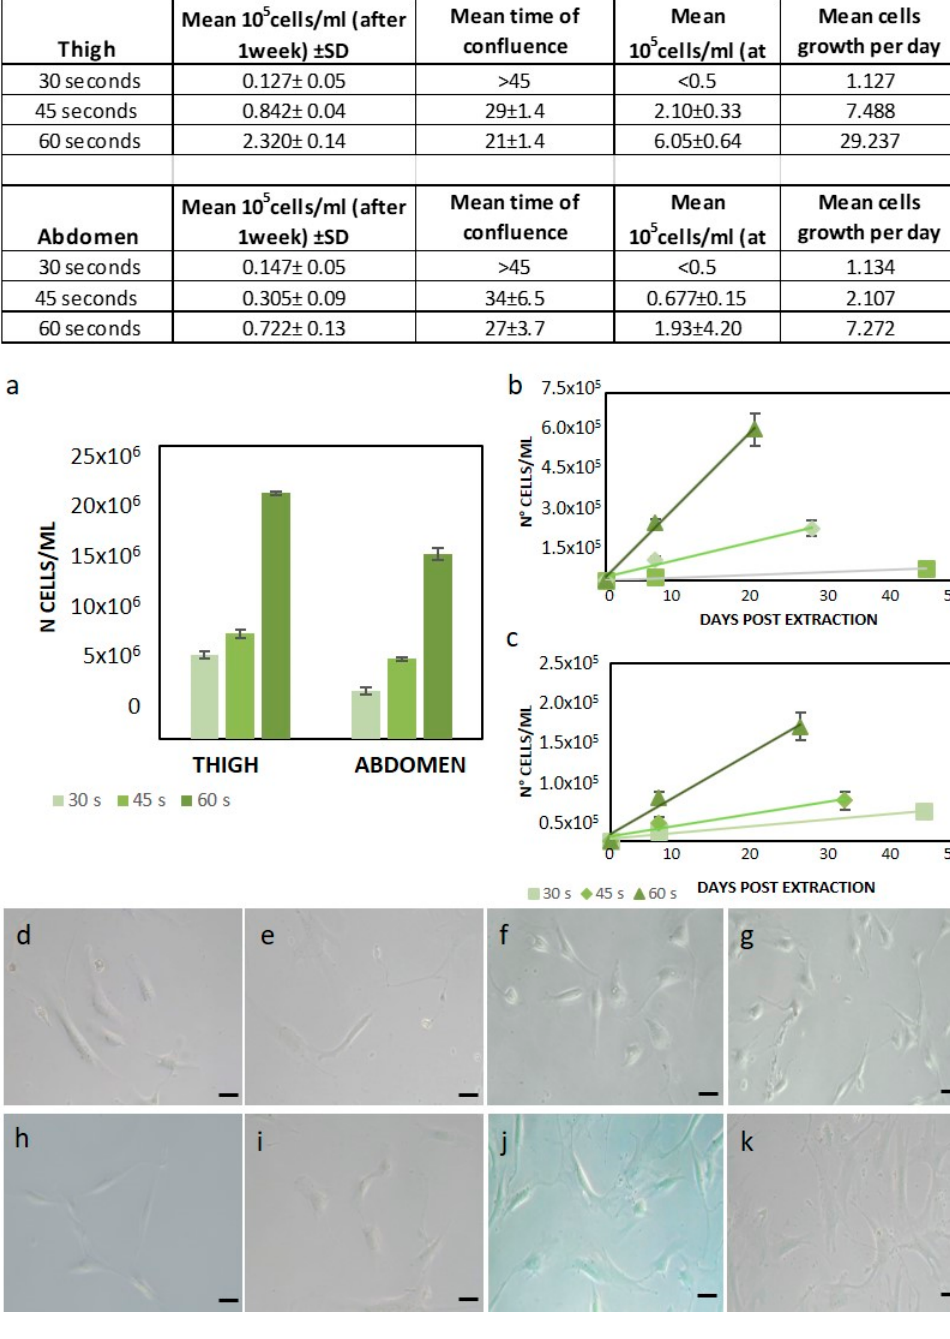
Figure 2. Rigenera ® method optimization. The tabs show all of the results obtained. ( a ) Cell viability test with the trypan blue exclusion method. At passage 0, the number of total cells was much higher with the 60 s Rigenera ® treatment compared to the other timings (30 and 45 s). After one week, the number of pure adipose-derived stem cells (ASCs) was still higher with the 60 s Rigenera ® treatment in both the thigh ( b ) and abdomen ( c ). Microscopic images (resolution 10×) of cells extracted from the thigh ( d – f ) and abdomen ( h – k ) with the Rigenera ® device operating at different timings of 30 s ( d , h ), 45 s ( e , i ), and 60 s ( f , j ), and the enzymatic method ( g , k ). Next, the cells obtained from 60 s treatment were compared with those obtained with the enzymatic method. After one week of culture, the Rigenera ® cell yield for the thigh was 62% and for the abdomen, was around 25%, compared to the enzymatic method (see the tab in Figure 3).